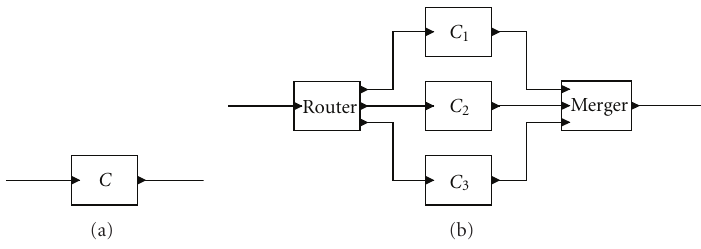
Figure 13: Adaptation pattern for parallelization. Component in (a) is parallelized by three as shown in (b).